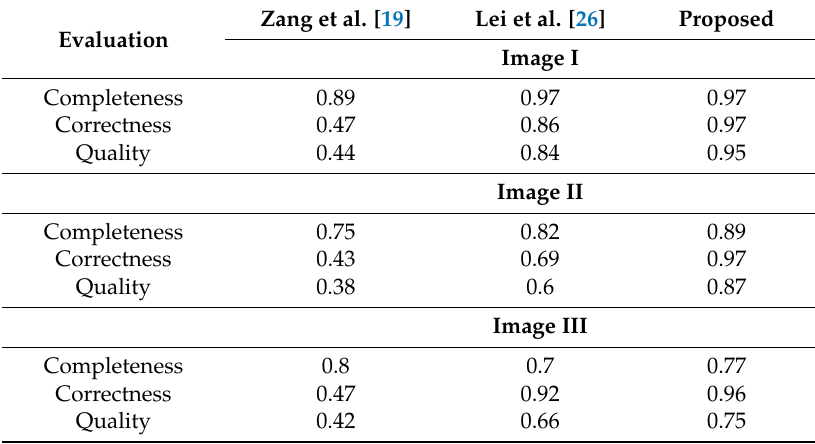
Table 4. Performance of the three road-extraction